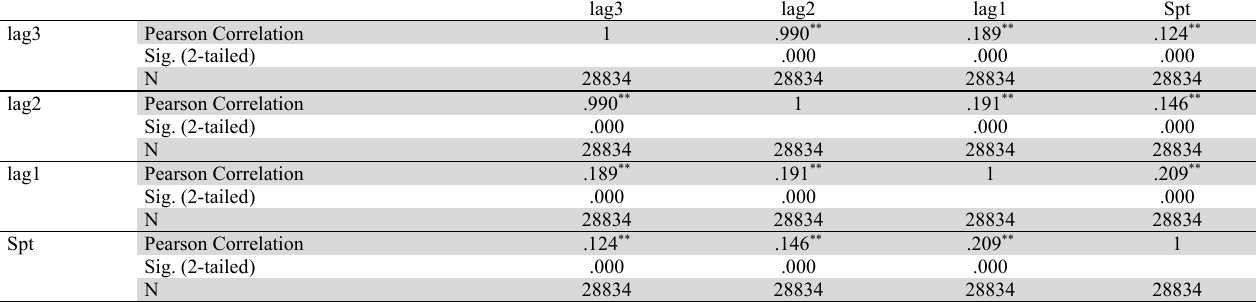
Pearson Correlation Coefficient Test Results